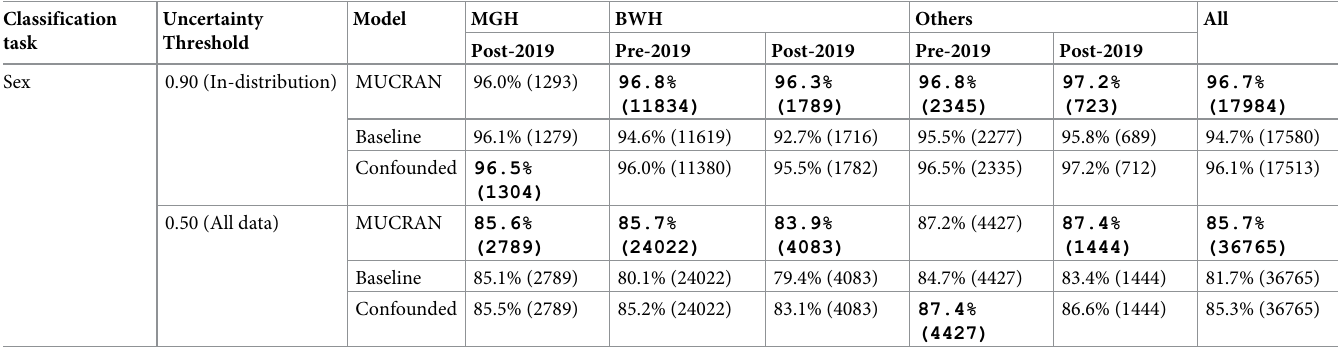
Table 2. Results for sex classification. Classification